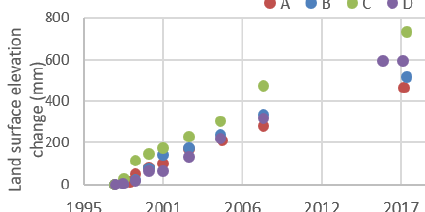
Figure 3. Land-surface elevation change in the Twitchell Island managed wetland. A, B, C and D are sites for sedimentation ero- sion measurements.